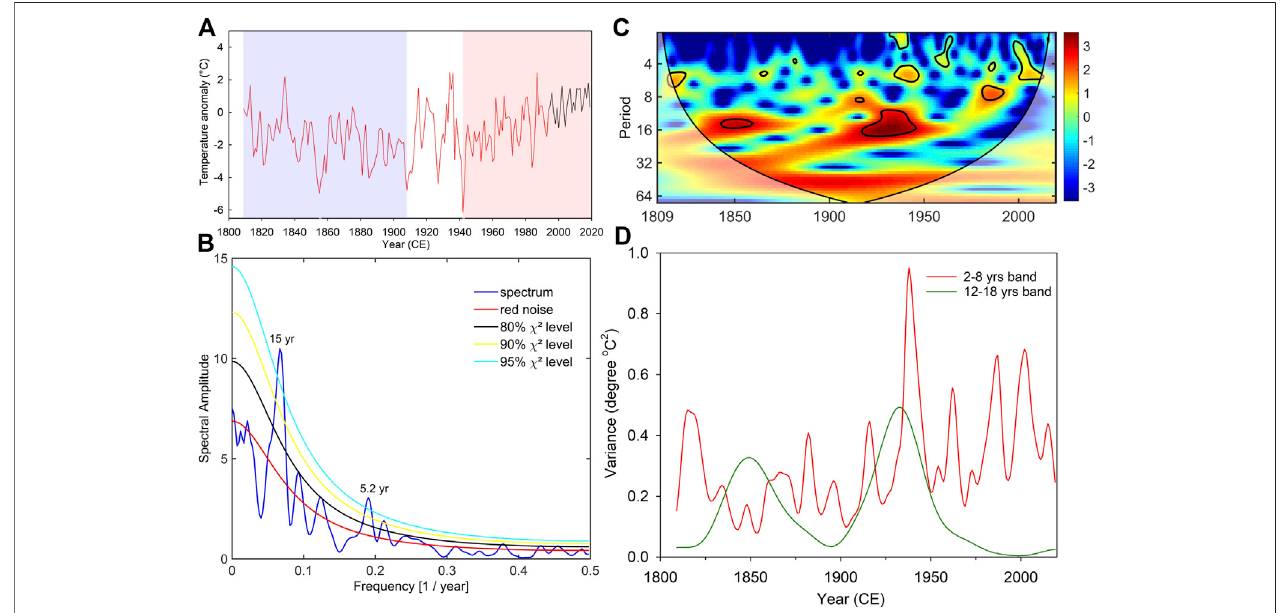
FIGURE5 |(A) Reconstructed temperature anomaly record combined withERA5 surfaceair temperature anomaly records(1809 – 2019 CE). (B) Spectral analysis of temperature anomaly shows signi fi cant periodicities of 15 and 5.2 years (95% χ 2 level). (C) Wavelet analysis of the temperature anomaly record highlights signi fi cant periodicities in the color band. (D) Scaled average variance analysis at two bands, namely, 2 – 8 years and 12 – 18 years frequency bands.